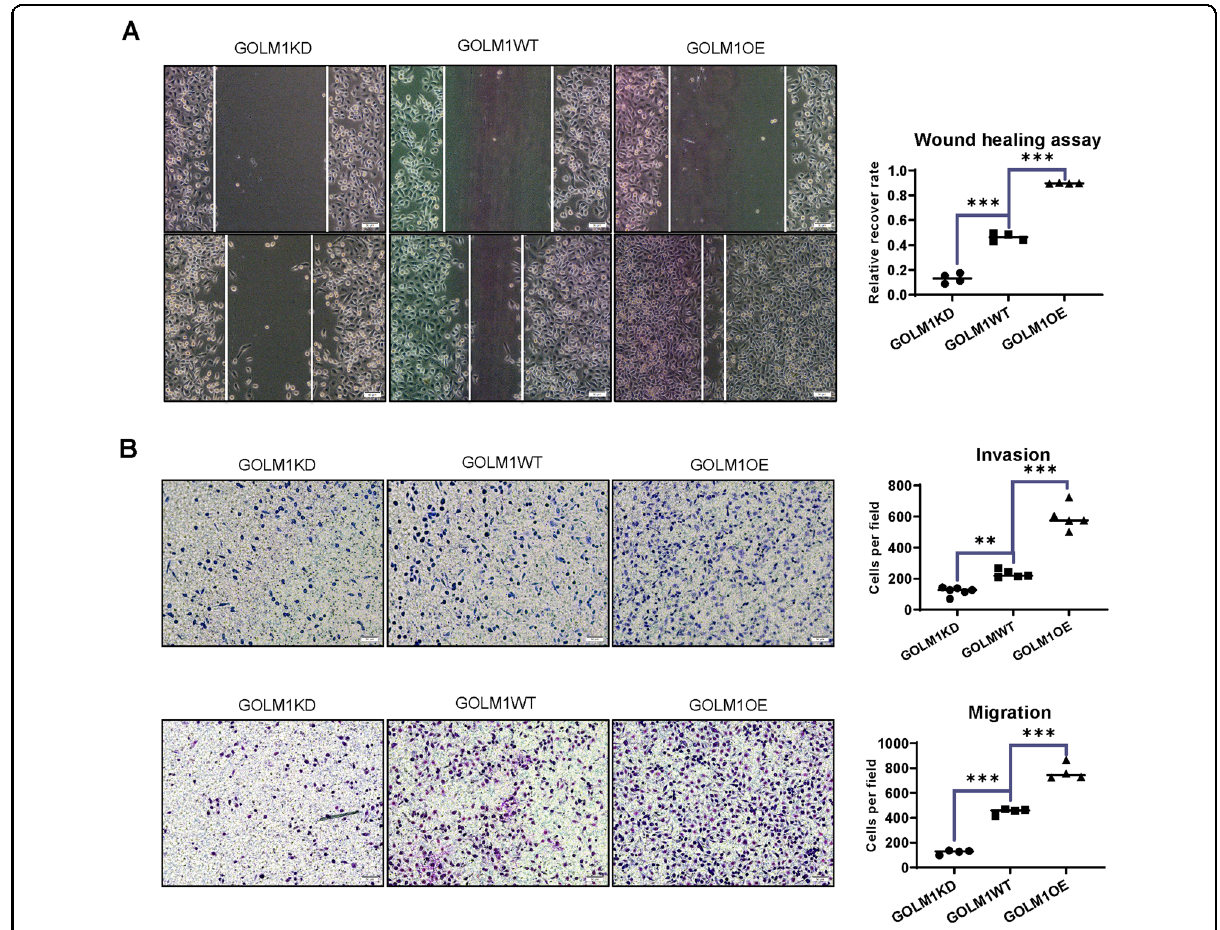
Fig. 4 GOLM1 promotes lung cancer cell proliferation, migration, and invasion in vitro. A The wound healing ability of different cell lines were evaluated 24 h after seeding. B Transwell assays were employed to evaluate the invasion ability and migration ability in different cell lines. GOLM1KD = GOLM1 knockdown group, WT wild-type group, GOLM1OE GOLM1 overexpression group. Data were means ± SEM. * P < 0.05, ** P < 0.01, *** P < 0.001, n =